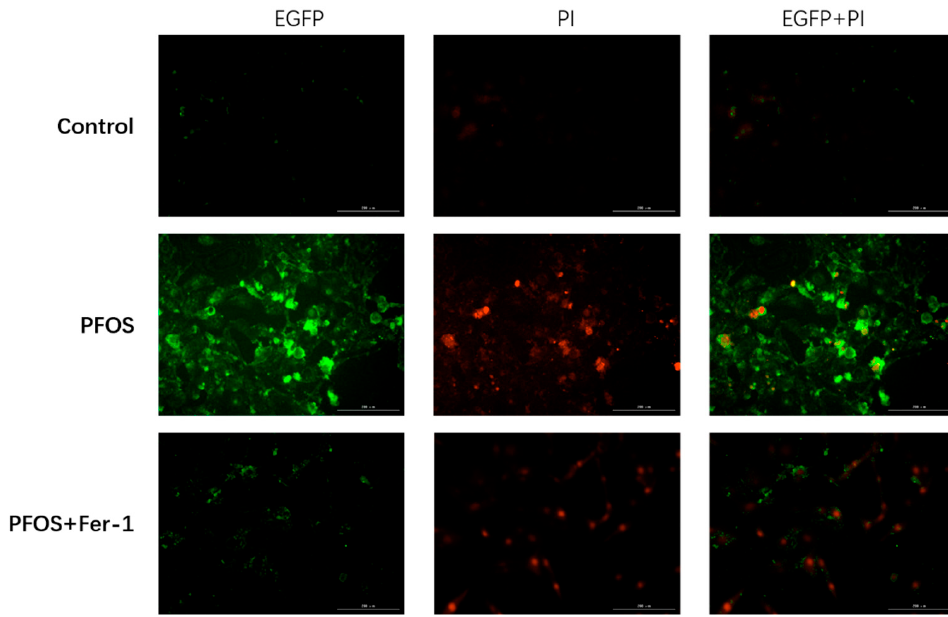
Figure 11. Annexin V ‐ EGFP staining of HK ‐ 2 cells exposed to PFOS or/and Fer ‐ 1. Normal living cells are not colored by Annexin V ‐ EGFP and PI, cells with early apoptosis are only stained by Annexin V ‐ EGFP and colored green; those stained by PI are dead cells and colored red; necrotic cells and cells with late apoptosis can be stained by Annexin V ‐ EGFP and PI at the same time.